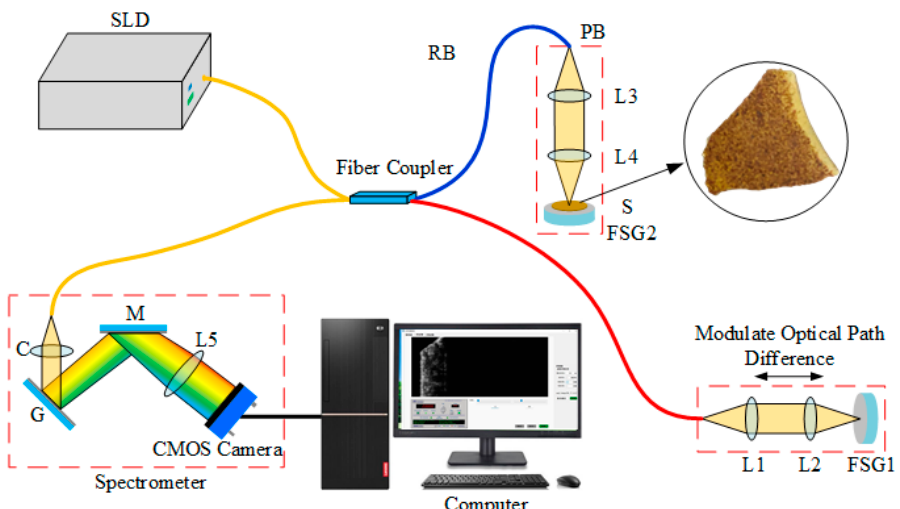
Figure 1. Schematic diagram of the SD-OCT. SLD: superluminescent diode; MS: mating sleeve; FC: fiber coupler (50:50); BL: bearing liner; PB: probe beam; RB: reference beam; G: grating; C: collimator; M: mirror; L: lens; FSG: fused silica glass; S: sample; RB: reference beam; PB: probe beam.